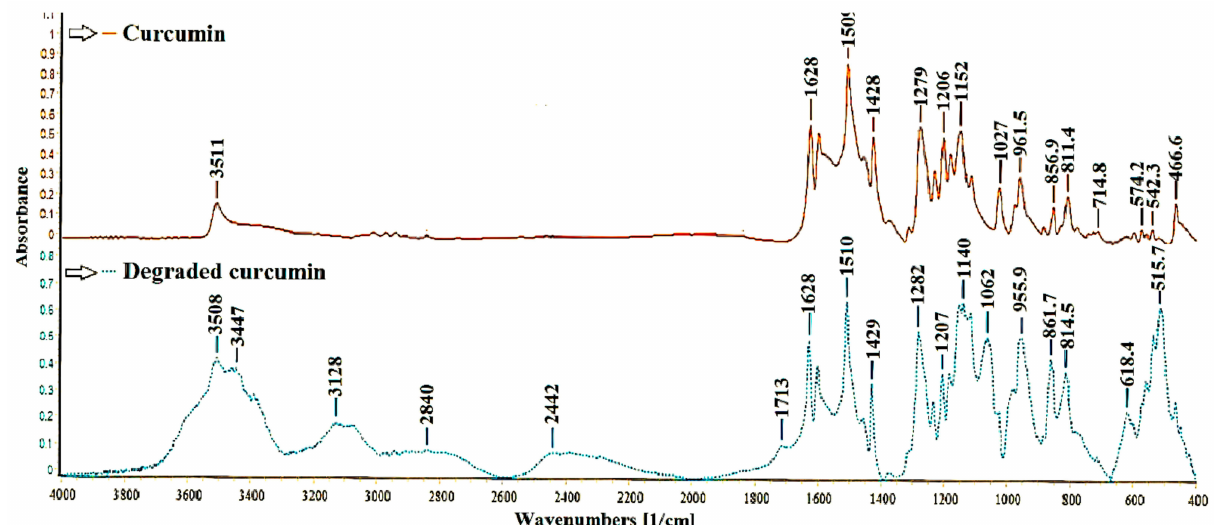
Figure 2. Fourier-transform infrared (FTIR) spectrum for degraded curcumin in the presence of light and air for 28 days compared to the FTIR spectrum of non-degraded